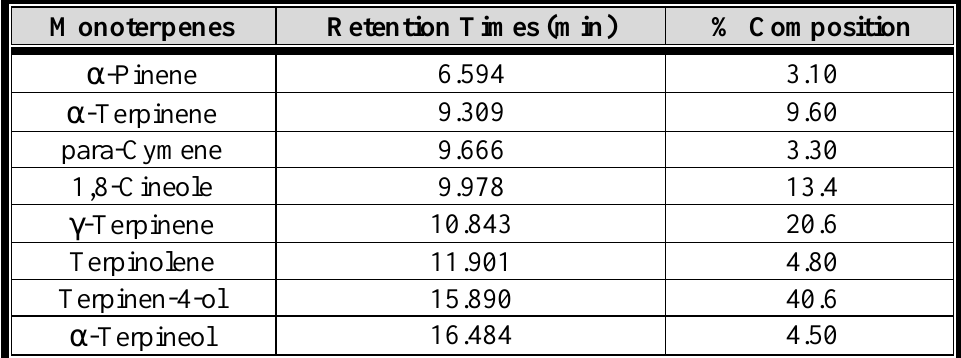
Table 1. Retention times and composition of the target